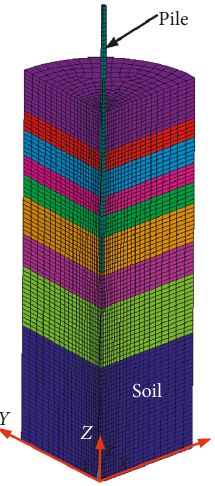
Figure 3: A single pile